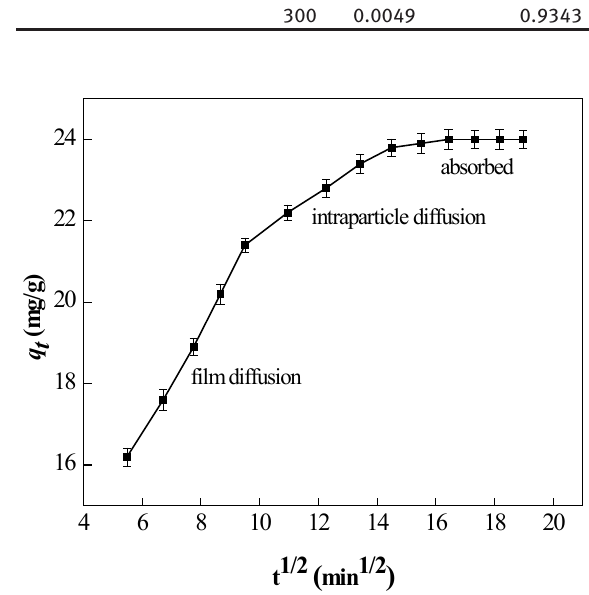
Figure 2: Intraparticle diffusion plot for ammonium adsorption by